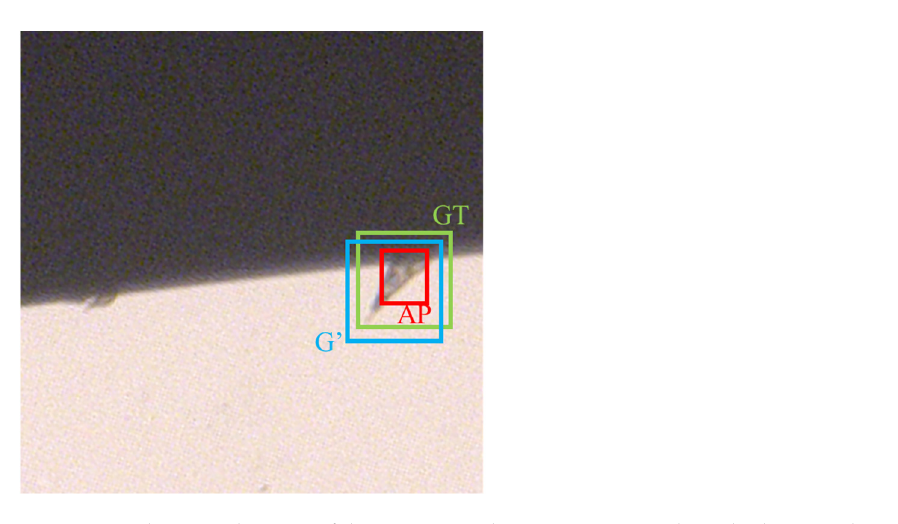
Figure 7. A schematic diagram of the concept in the RPN regression branch; the green box represents the ground truth, the red box represents the positive anchor, and the blue box represents the regres ‐ sion network result .